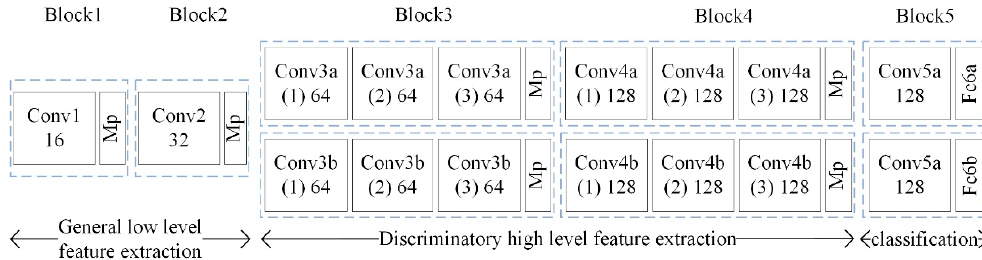
Figure 6. Improved C3D-M structure with 16, 32, 64 and 128 output channels per block. Numbers in brackets are the orders of convolution in blocks. Mp: mixed pooling.